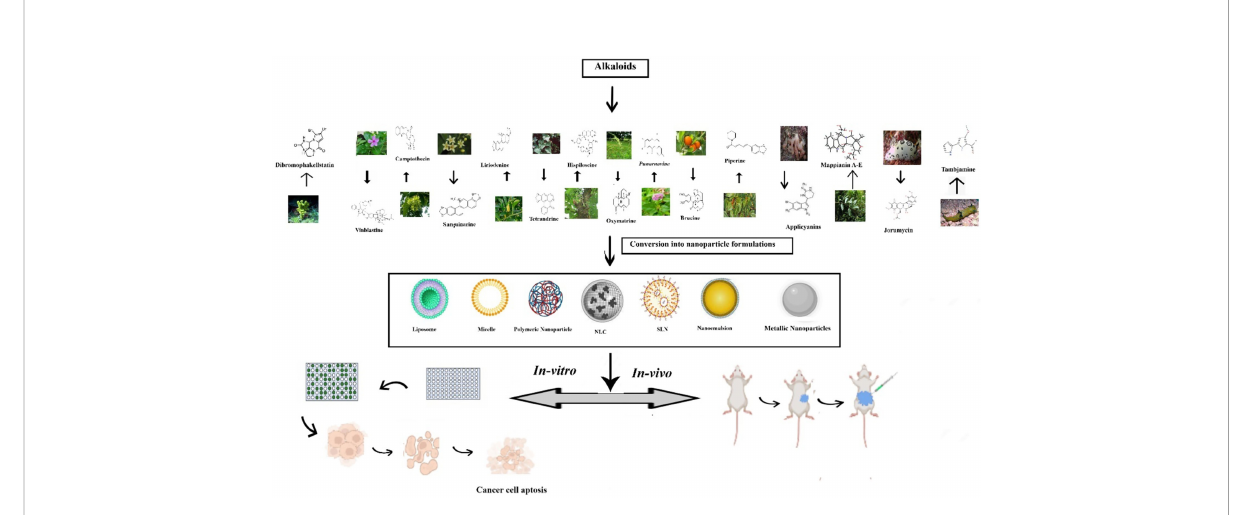
FIGURE 2 Nanoformulations of alkaloids in the management of lung cancer.